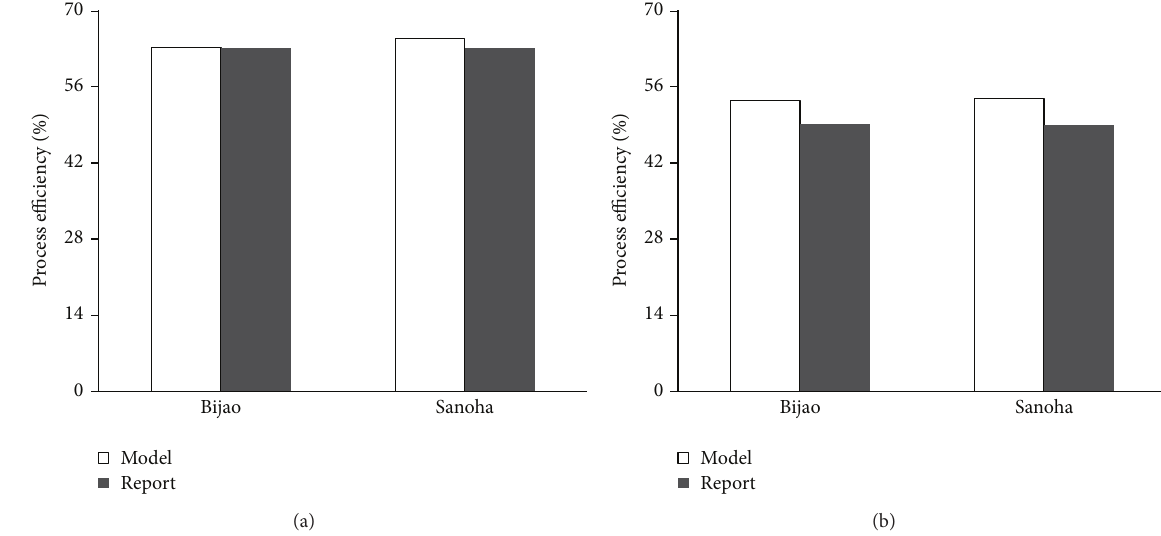
Figure 12: Process efficiency (%). Comparison between simulated and reported data for two Colombian coals; (a) slurry feeding technology and (b) dry feeding